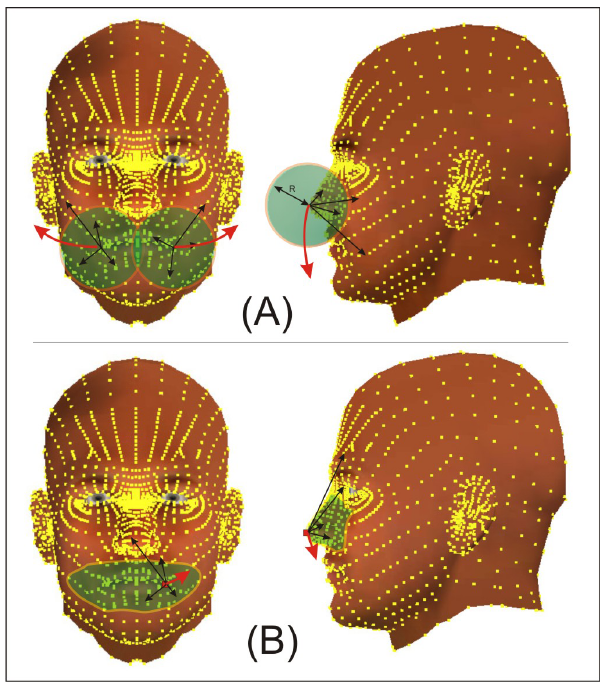
Figure 9. (A) Proposed system of spherical influence zones. (B) Noh’s system of influence